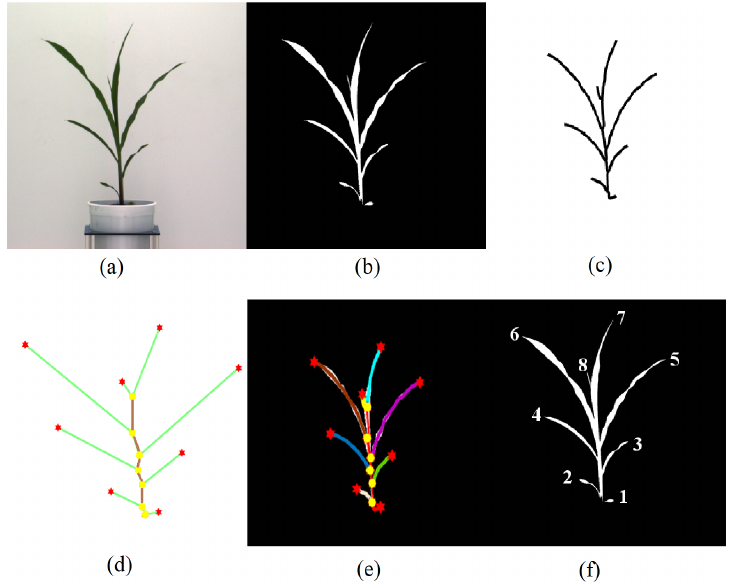
Figure 1. Image-based plant phenotyping computation pipeline: ( a ) original image; ( b ) binary image; ( c ) plant skeleton; ( d ) graphical representation of the plant with tips and collars identified; ( e ) plant skeleton with leaves marked with different colors; and ( f ) leaf labeling in order of emergence.